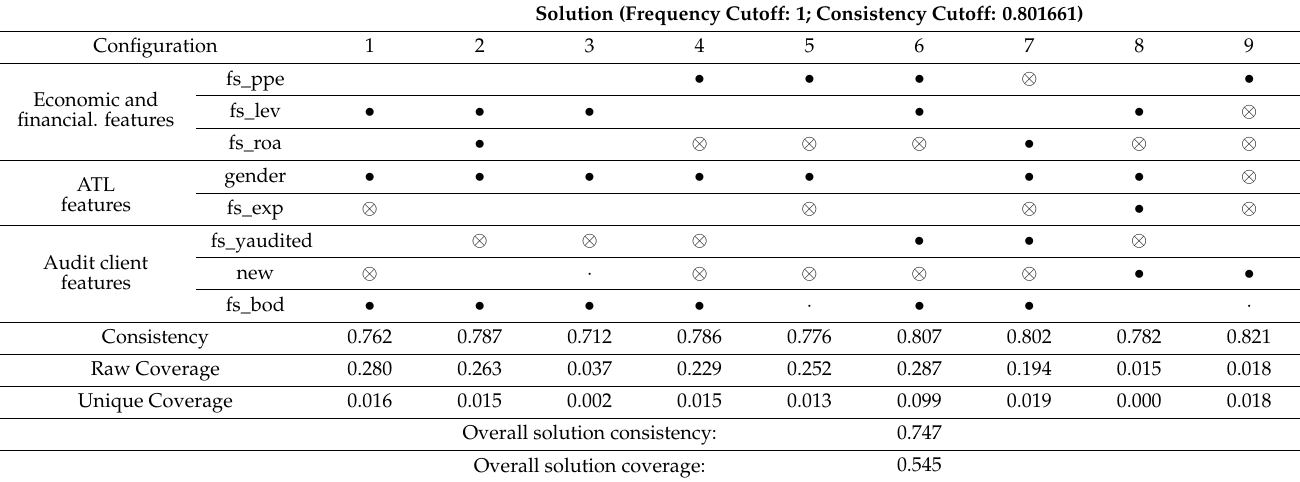
Table 6. Configurations sufficient for the absence of internal control (Outcome: ~fs_intcontrol).